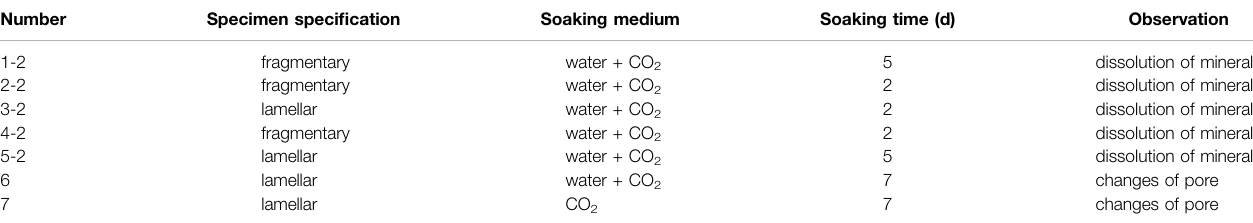
TABLE 4 | Scheme of soaking